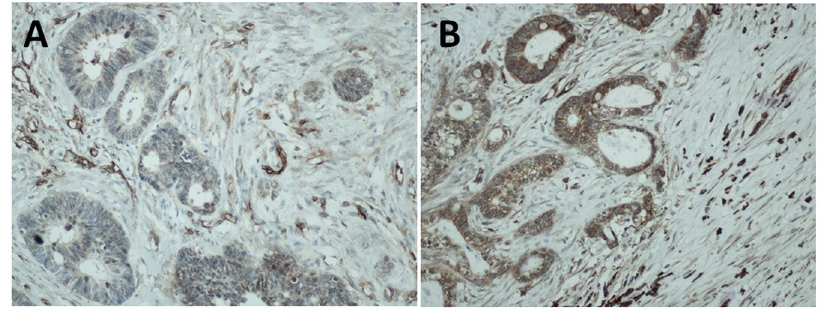
Figure 1. Immunohistochemical staining for caveolin-1. ( A ) Weak stromal caveolin-1 (CAV1) expression in colorectal liver metastases. ( B ) Strong stromal caveolin-1 (CAV1) expression in colorectal liver